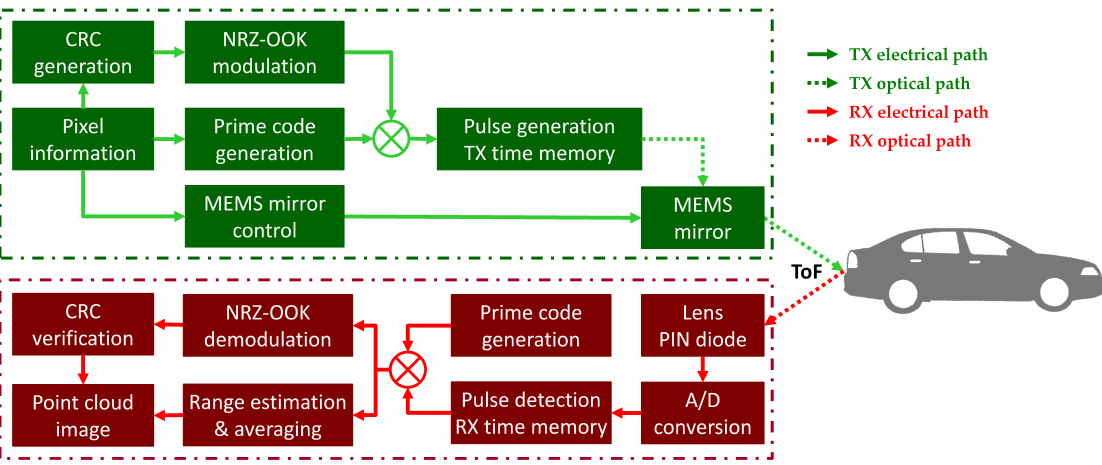
Figure 1. Overall architecture and operation flow of the proposed scanning light detection and ranging (LIDAR)